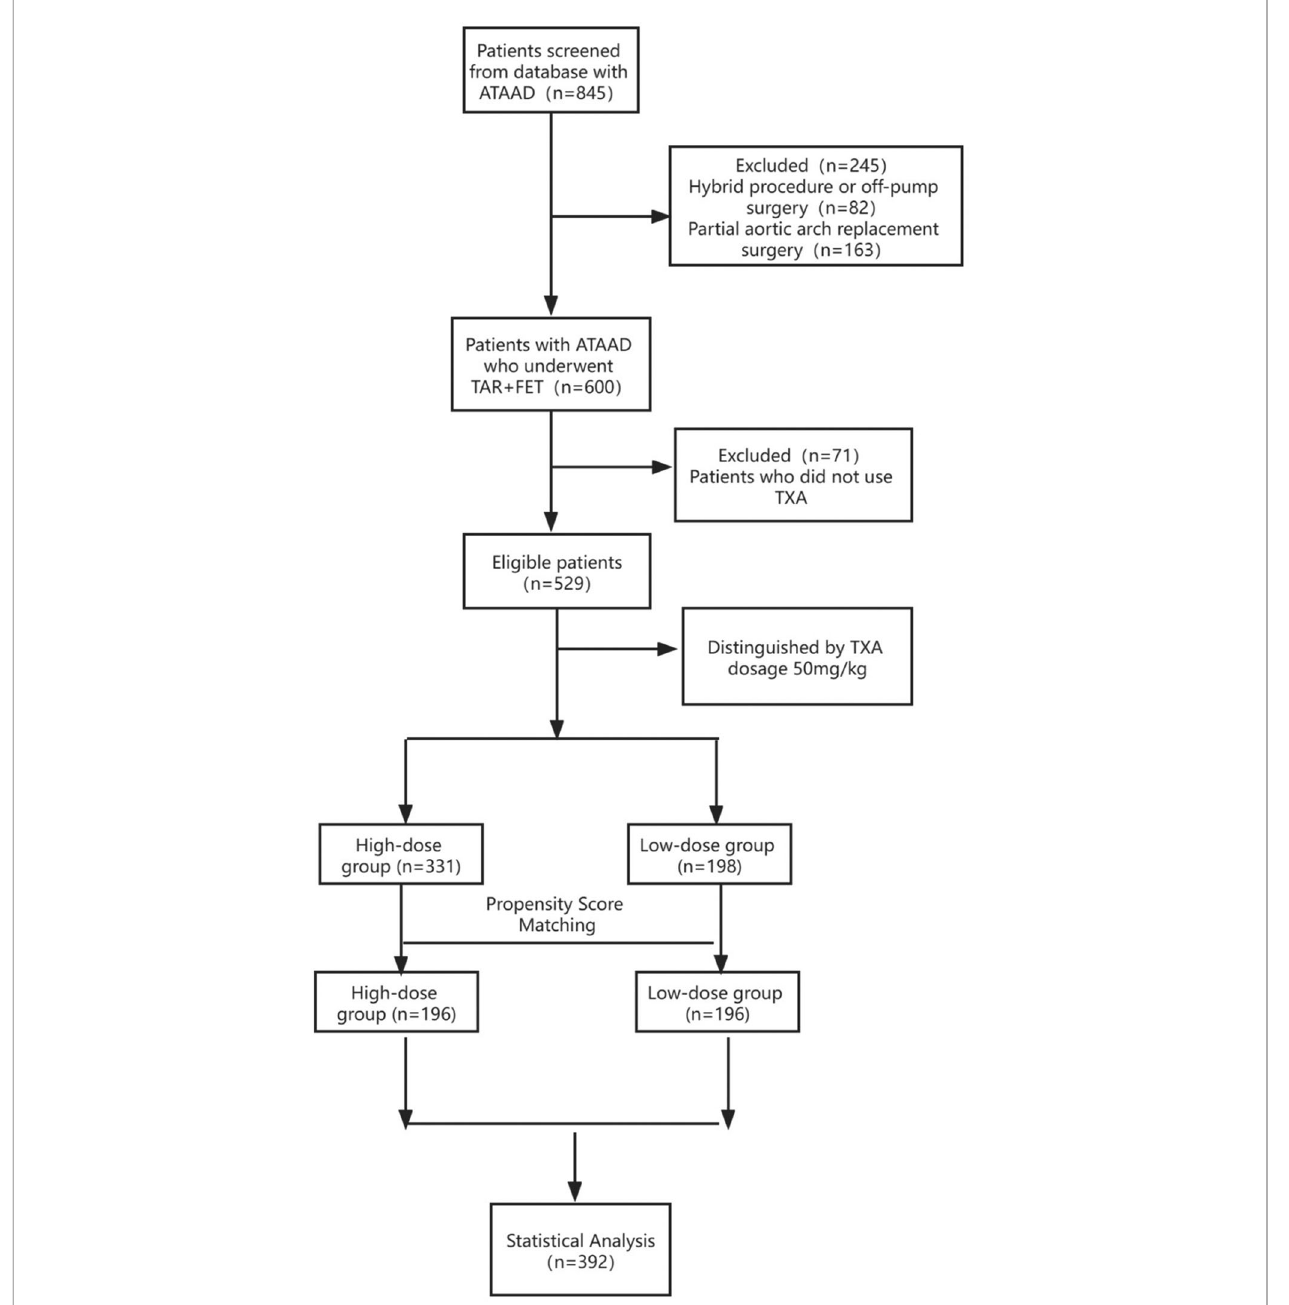
FIGURE 1 | Study fl owchart. ATAAD, acute type A aortic dissection; TAR+FET, total arch replacement and frozen elephant trunk; TXA, tranexamic